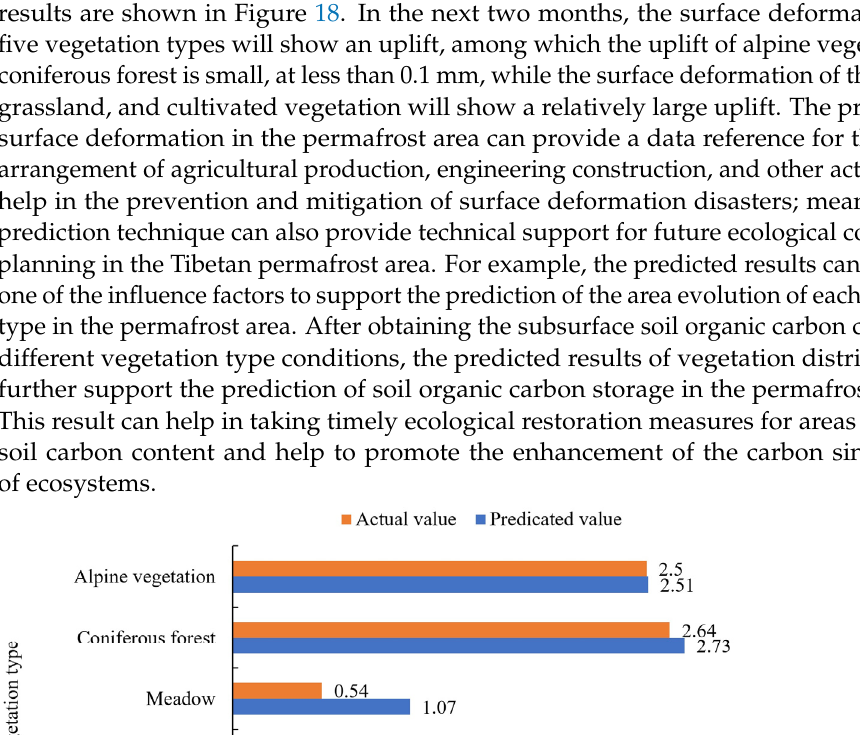
Figure 17. Predicted results of surface deformation in the study area.